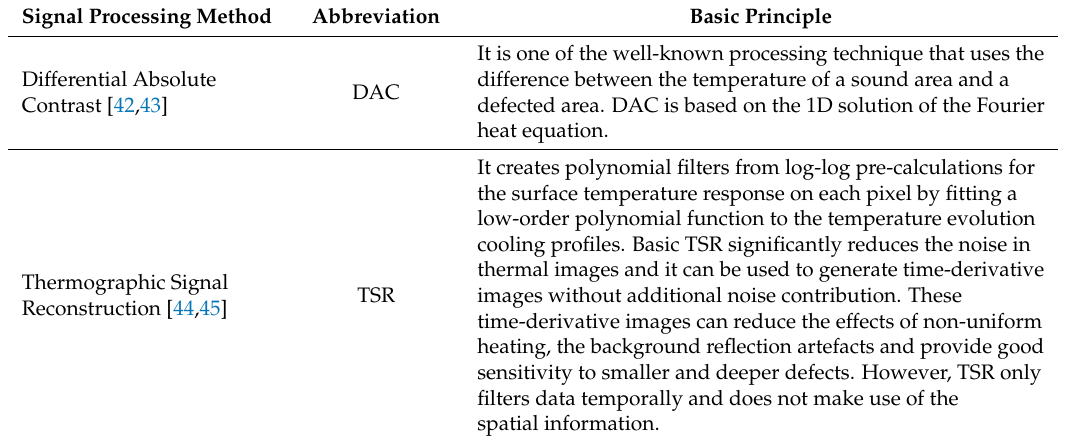
Table 3. Summary of signal processing techniques used for